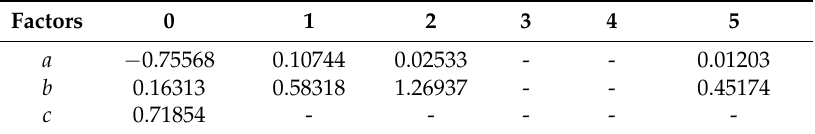
Table 5. Values for a , b and c factors of the df min fit, used to model df min for given kt , kt var , AM and up/down time. The RMS of residuals is 0.0480.